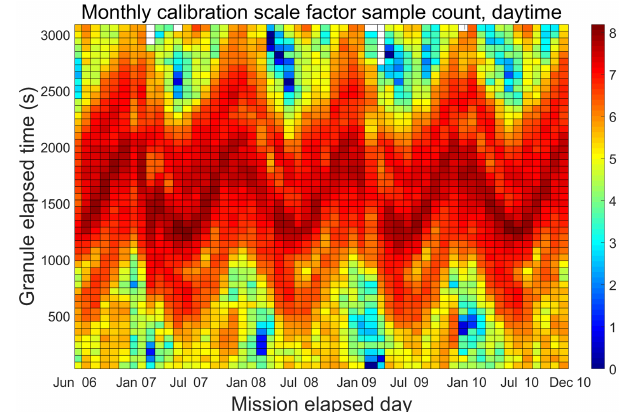
Figure 6. Monthly counts of V3 daytime scale factor calculations as a function mission elapsed time ( x axis) and granule elapsed time ( y axis). Colors are displayed on a log 10 scale, so that dark reds indicate many thousands of samples, whereas dark blues indicate one or two samples. Regions where no calibration quality clouds were detected are shown in